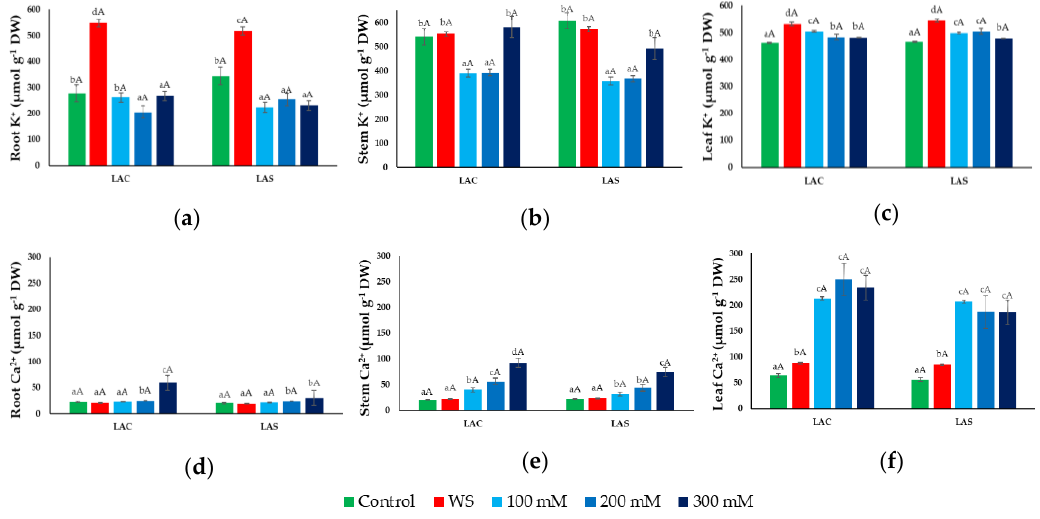
Figure 6. Ion contents under water deficit and salt stress conditions. Potassium (K + ) ( a , b , c ) and calcium (Ca 2 + ) ( d , e , f ) concentrations in roots ( a , d ), stems ( b , e ), and leaves ( c , f ) of L. angustifolia var. ‘Codreanca’ (LAC) and var. ‘Sevtopolis’ (LAS) plants after 30 days of growth under control conditions, in the presence of the indicated NaCl concentrations or subjected to water stress (WS) (completely withholding irrigation). DW, dry weight. Bars represent means ± SE ( n = 5). Di ff erent lowercase letters above the bars indicate significant di ff erences between treatments for each variety, and di ff erent uppercase letters indicate significant di ff erences between the two varieties for plants undergoing the same treatment, according to the Tukey test ( α = 0.05).